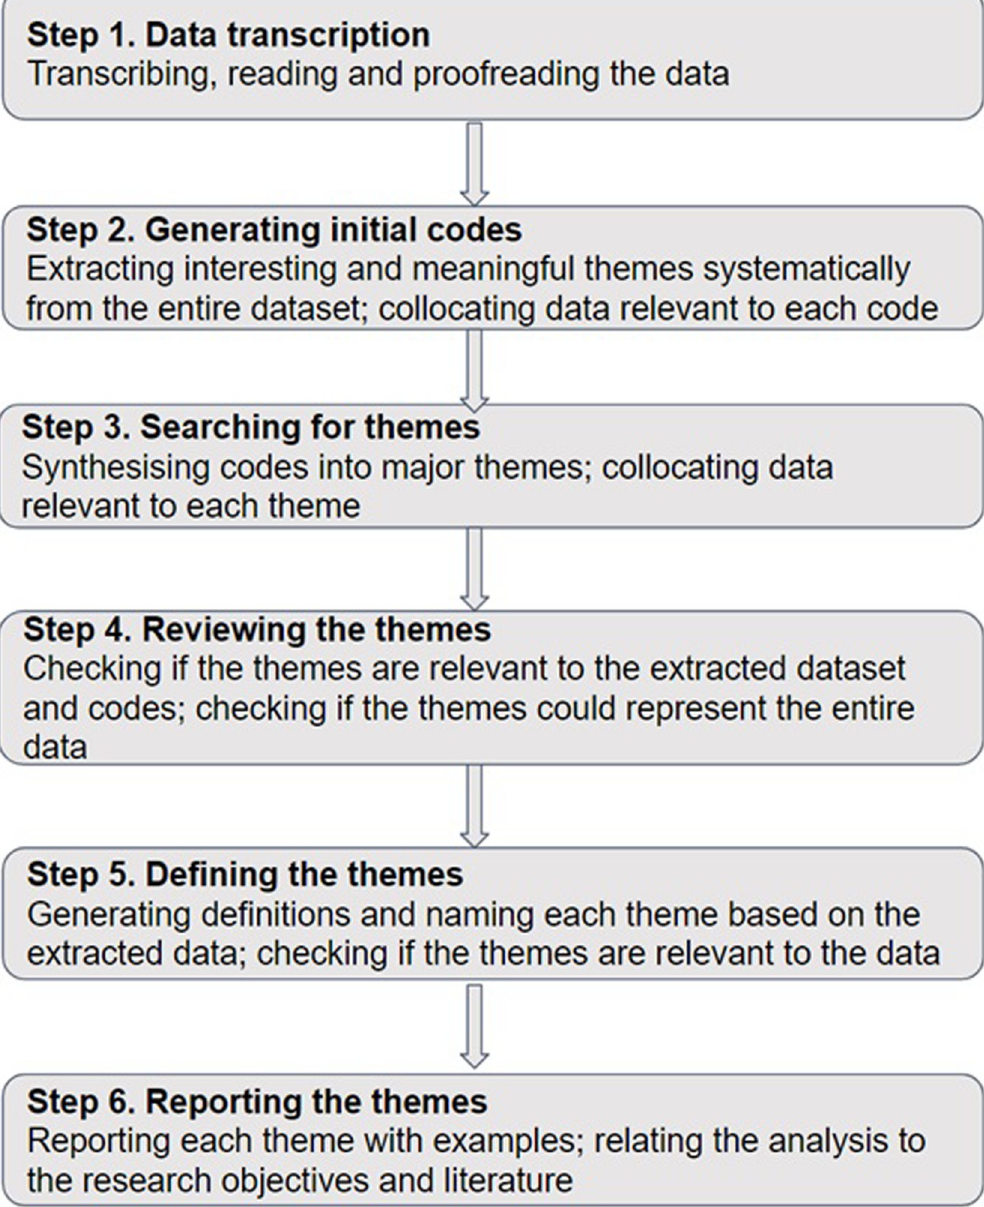
Fig 1. Processes of thematic analysis